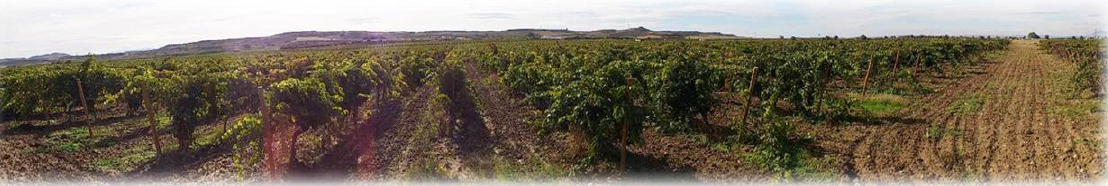
Figure 4. Cabernet Sauvignon